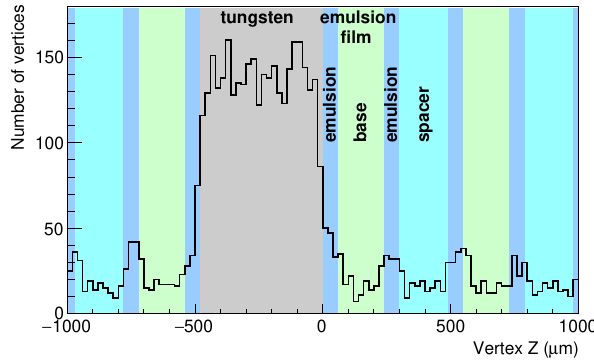
Figure 17 . Reconstructed vertex position distribution in Z. The correspondence with the detector structure is clearly visible.